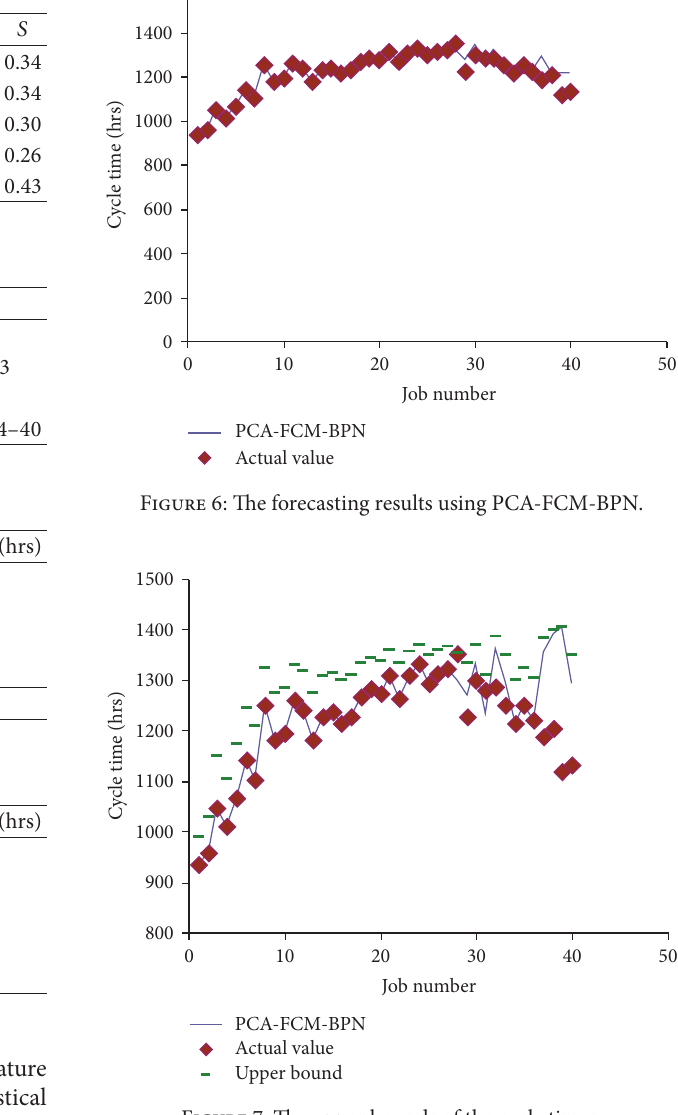
Figure 7: The upper bounds of the cycle